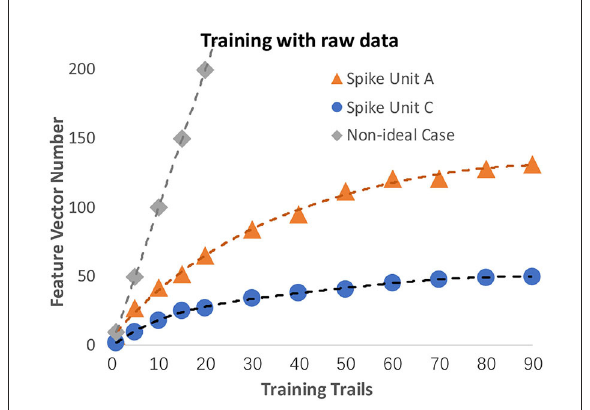
FIGURE10 The SNNs design qualities performances. The SGF units A and C are shown in orange and blue color, while a non-ideal design case is shown in gray color.